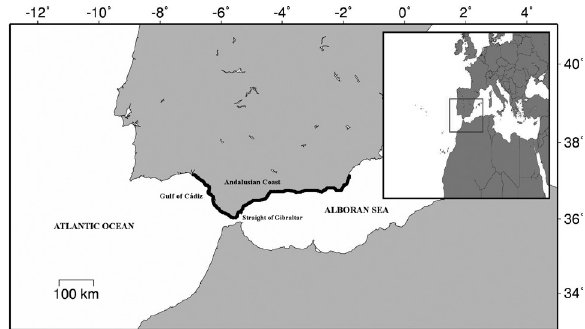
Fig 1 . – The Andalusian coast, showing two regions: the Gulf of Cadiz (in the Atlantic Ocean) and the Alboran Sea (within the Medi- terranean